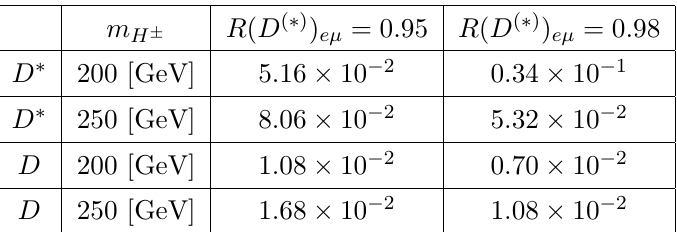
Table 4 . The upper bounds on j (cid:20) e;(cid:23) j from the lepton universality of B ! D ( (cid:3) ) l(cid:23) ( l = e; (cid:22) ). (cid:22)c We impose the upper bounds on R ( D ( (cid:3) ) ) e(cid:22) as R ( D ( (cid:3) ) ) e(cid:22) > 0 : 95 and R ( D ( (cid:3) ) ) e(cid:22) > 0 : 98 [67]. The process, B ! D (cid:3) ( D ) l(cid:23) , is labeled as D (cid:3) ( D ) on the (cid:12)rst column. The deviations should not exceed a few percent: R ( D (cid:3) ) = 1 : 04 (cid:6) 0 : 05 (cid:6) 0 : 01 [67]. e(cid:22)